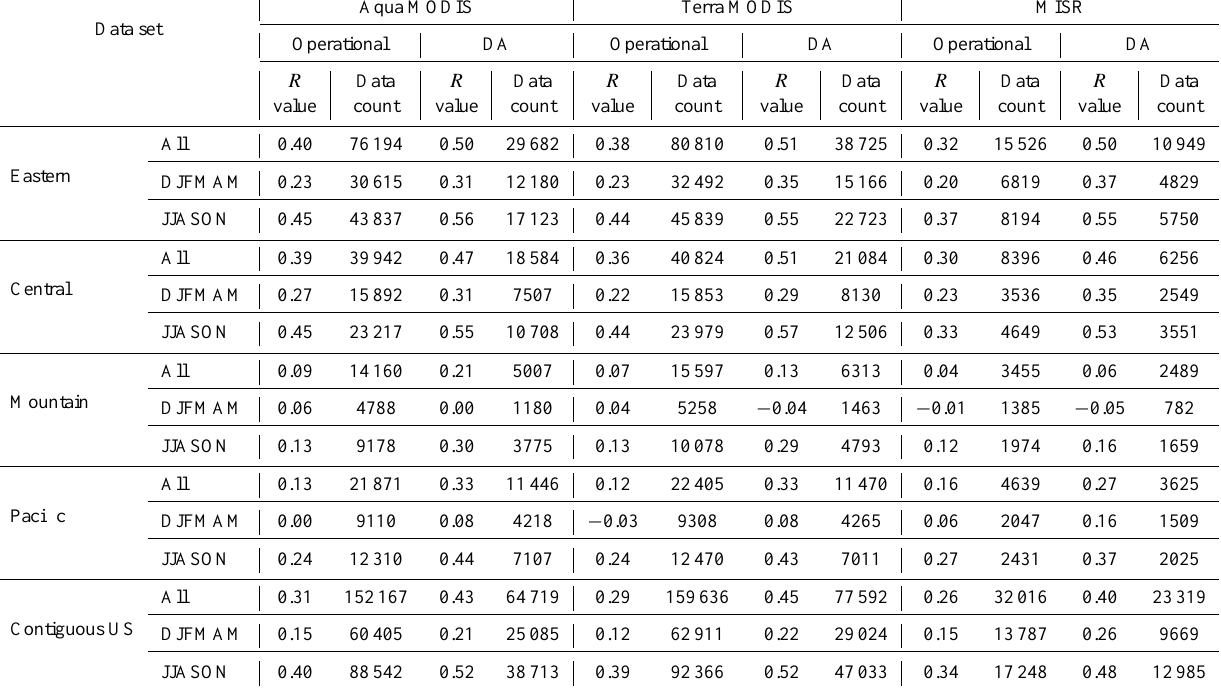
Table 2. Correlation coefficients and data counts of the 40km average operational Aqua/Terra MODIS and MISR AOD/hourly PM 2 . 5 collocation analyses for the eastern, central, mountain, and Pacific time zones and contiguous United States total for the entire 2-year (2008–